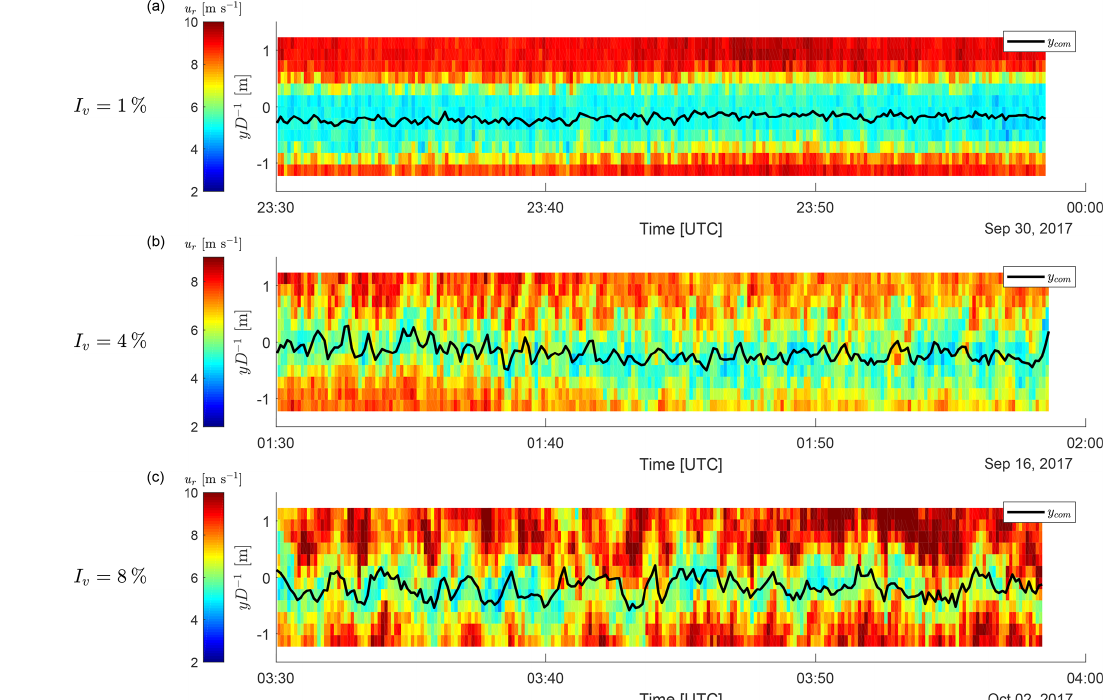
Figure 7. Time series of the radial velocity profiles from the wake-scanning Doppler lidar at xD − 1 = 6 for low (a) , medium (b) , and high (c) lateral turbulence intensity ( I v ). The three example cases were chosen to span the range of turbulence intensities present within the data set.